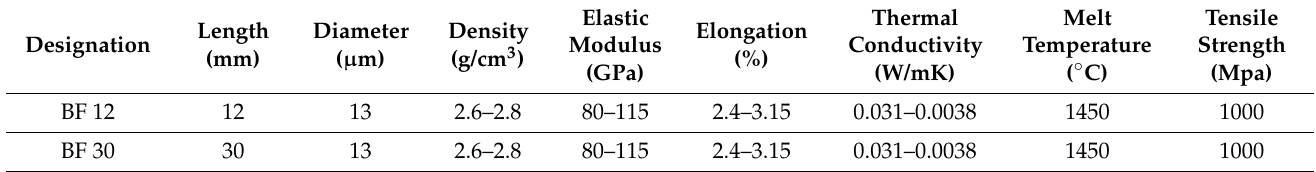
Table 2. Physical properties of basalt fibres [51,67–69].